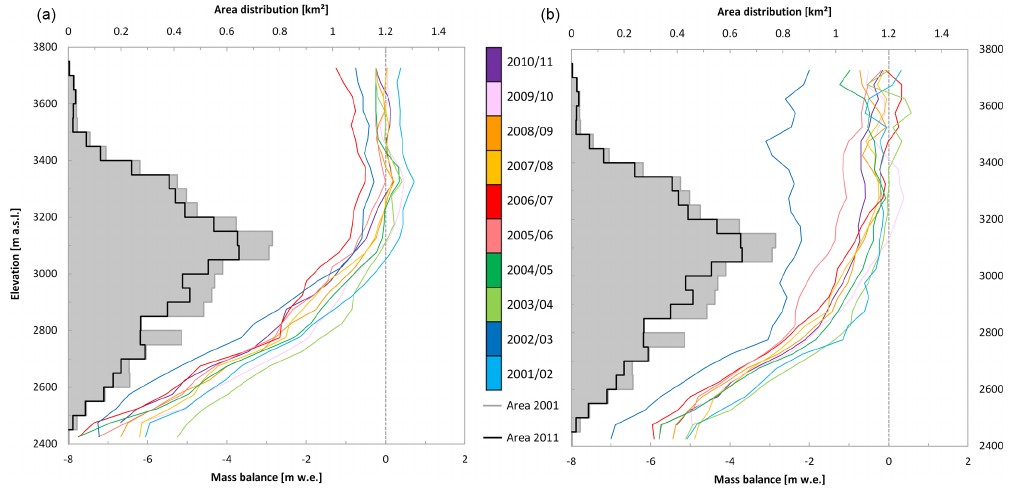
Figure 4. Altitudinal profiles of annual homogenized glaciological (a) and geodetic (b) mass balances over the study period. Note that vertical profiles of the two methods cannot be directly compared due to the effect of glacier dynamics not captured in the glaciological